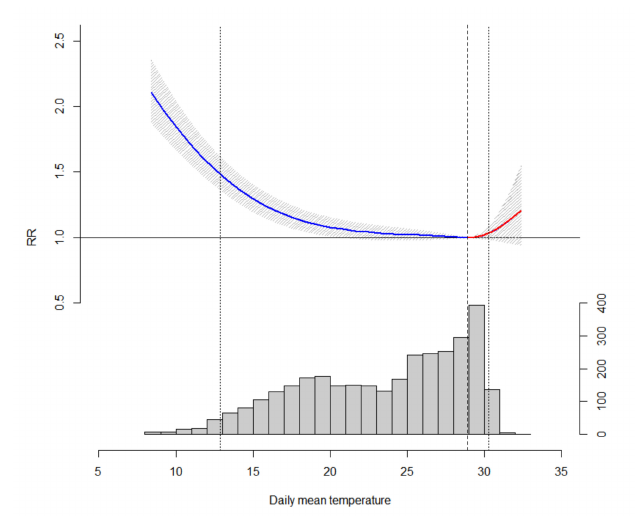
Figure 2. The cumulative e ff ect (lag 0–21 days) of daily mean temperature on non-accidental mortality during 2007 and 2015 with the distribution of daily mean temperature at the bottom (number of days). The dashed in the middle indicates the minimum mortality temperature (28.9 ◦ C) the two vertical lines on the sides indicates the 2.5th (12.9 ◦ C) and 97.5th (30.3 ◦ C) percentile of the daily temperature during study period.